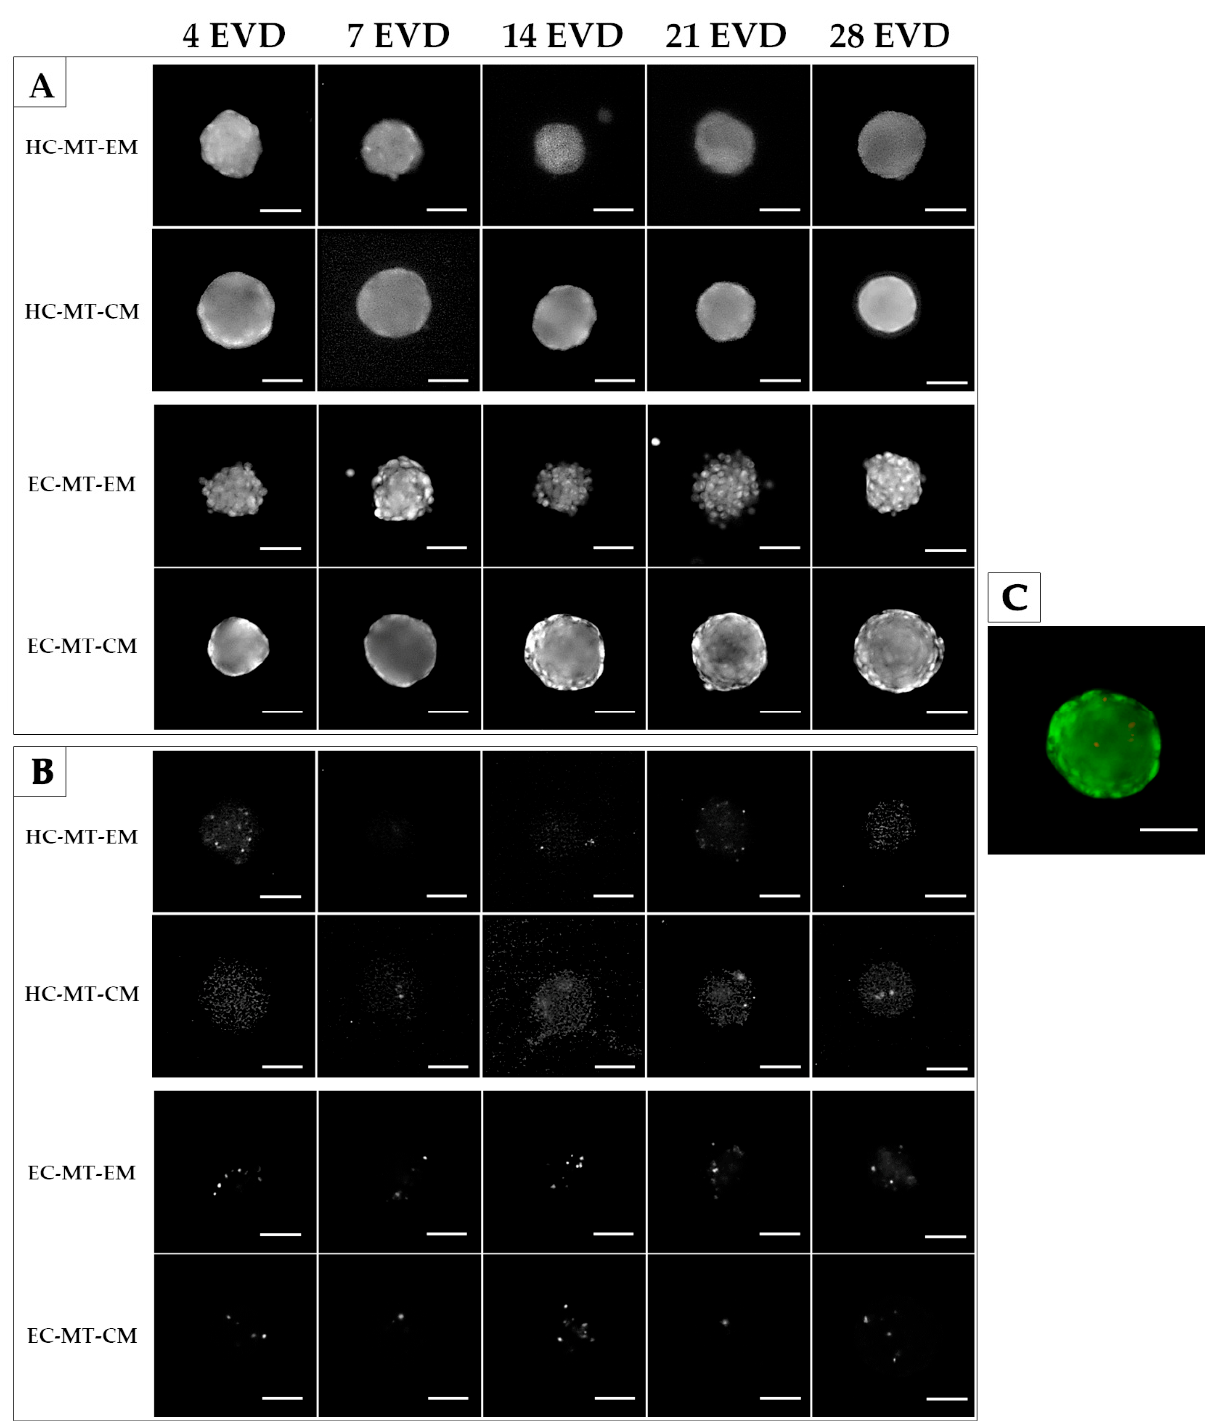
Figure 3. Time course of the Live/Dead assay of human chondrogenic MTs with CM and EM culture conditions. Color live/dead images were split into green channel ( A ) and red channel ( B ). A shows viable cells while B indicates the dead cells for each experimental condition. Note that all MTs generated are mainly composed of viable cells. A representative color image is also provided on the right ( C ). Scale bar = 50 µm.